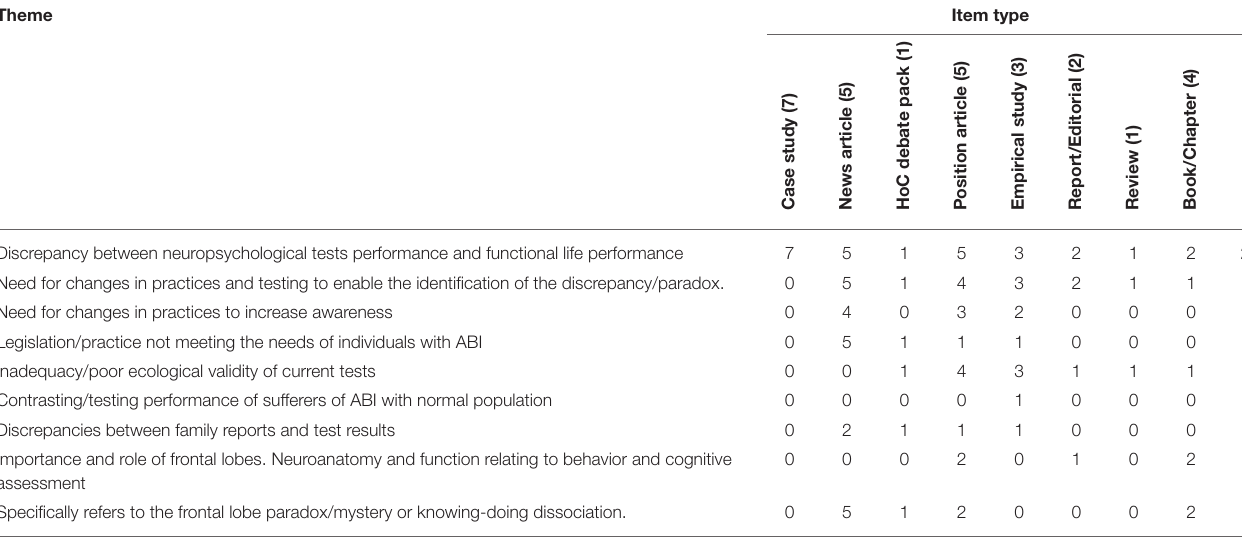
TABLE 3 | Themes identified within searched